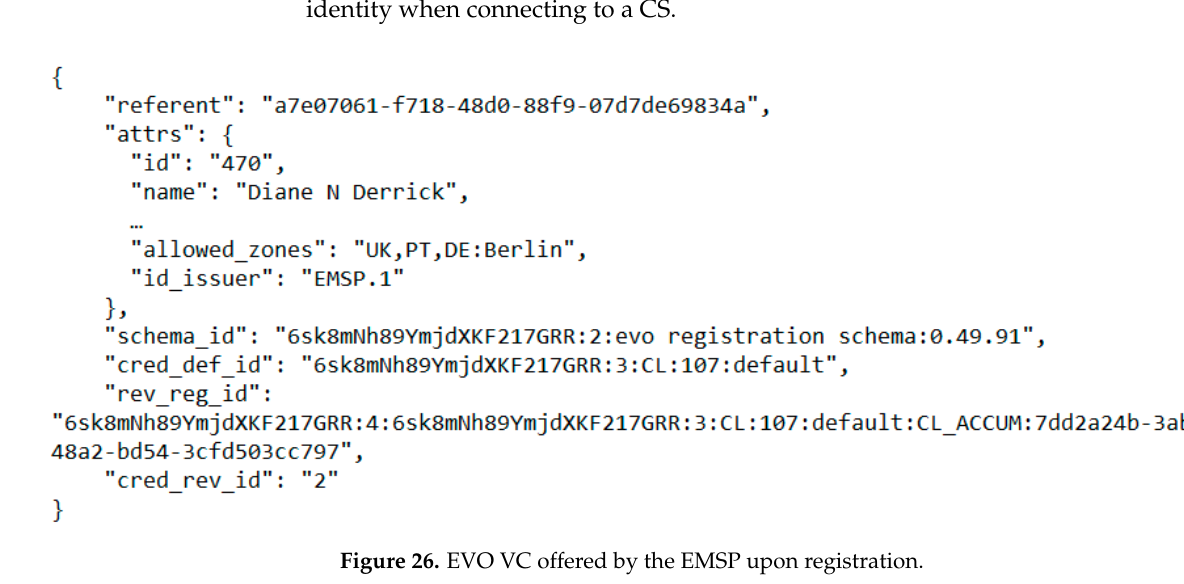
Figure 25. EMSP generated connection invitation.